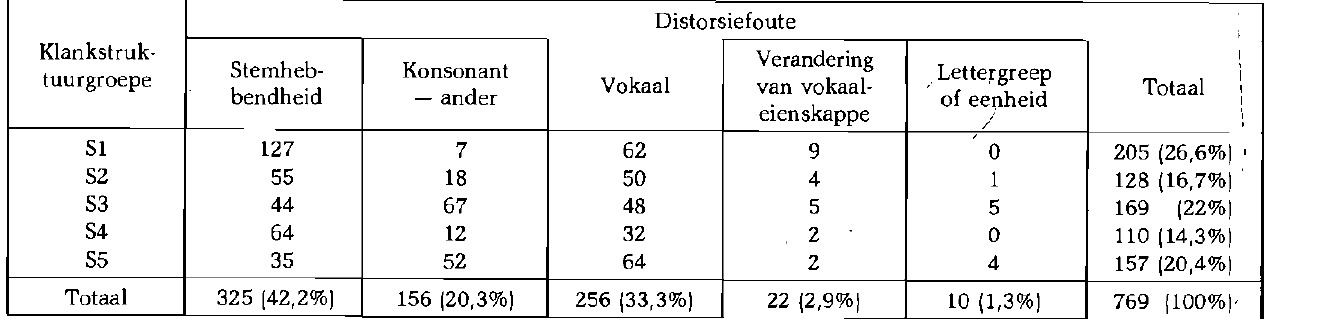
Tabel 3: Distorsie by die verskillende klankstruktuurgroepe: